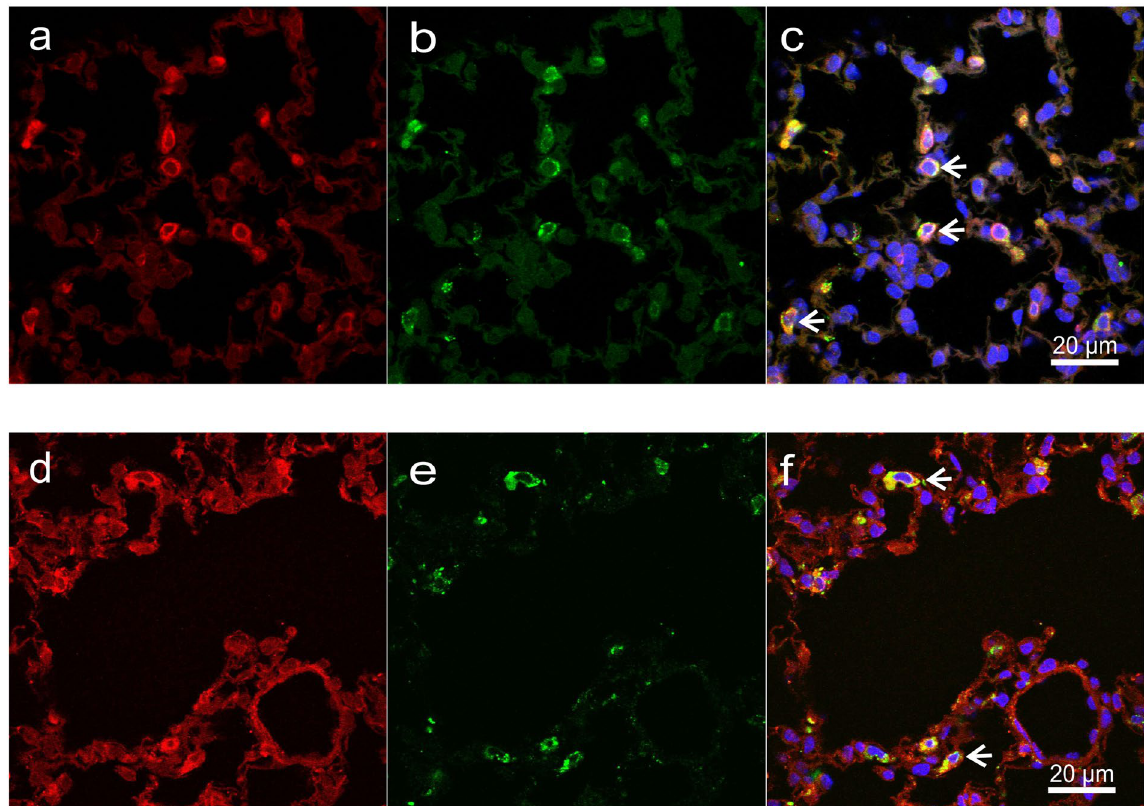
Figure 4. Lung ATII cells express COX-2 and COX-1. Lung sections from healthy, specific pathogen- free BALB/c mice were stained with an antibody detecting ( a ) COX-2 or ( d ) COX-1 (red) followed by immunodetection of ( b,e ) pro-surfactant protein C, a marker of type II alveolar epithelial cells (green). The samples were counterstained ( c,f ) with DAPI in order to visualize the nuclei. The overlays show that ( c ) COX-2 as well as ( f ) COX-1 is expressed in ATII cells (e.g. arrows). Images are representative for 4 independent